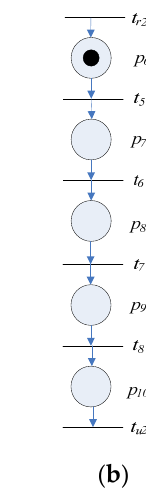
Figure 2. Examples of GJ